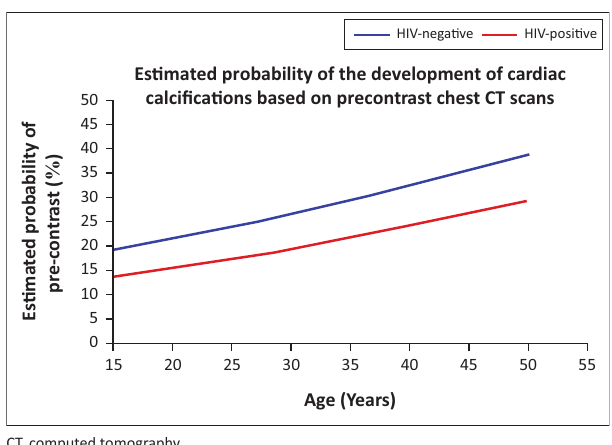
FIGURE 6: Demonstrates the numerical variance, in percentage, in the incidence of calcifications in the different age categories according to immune status.